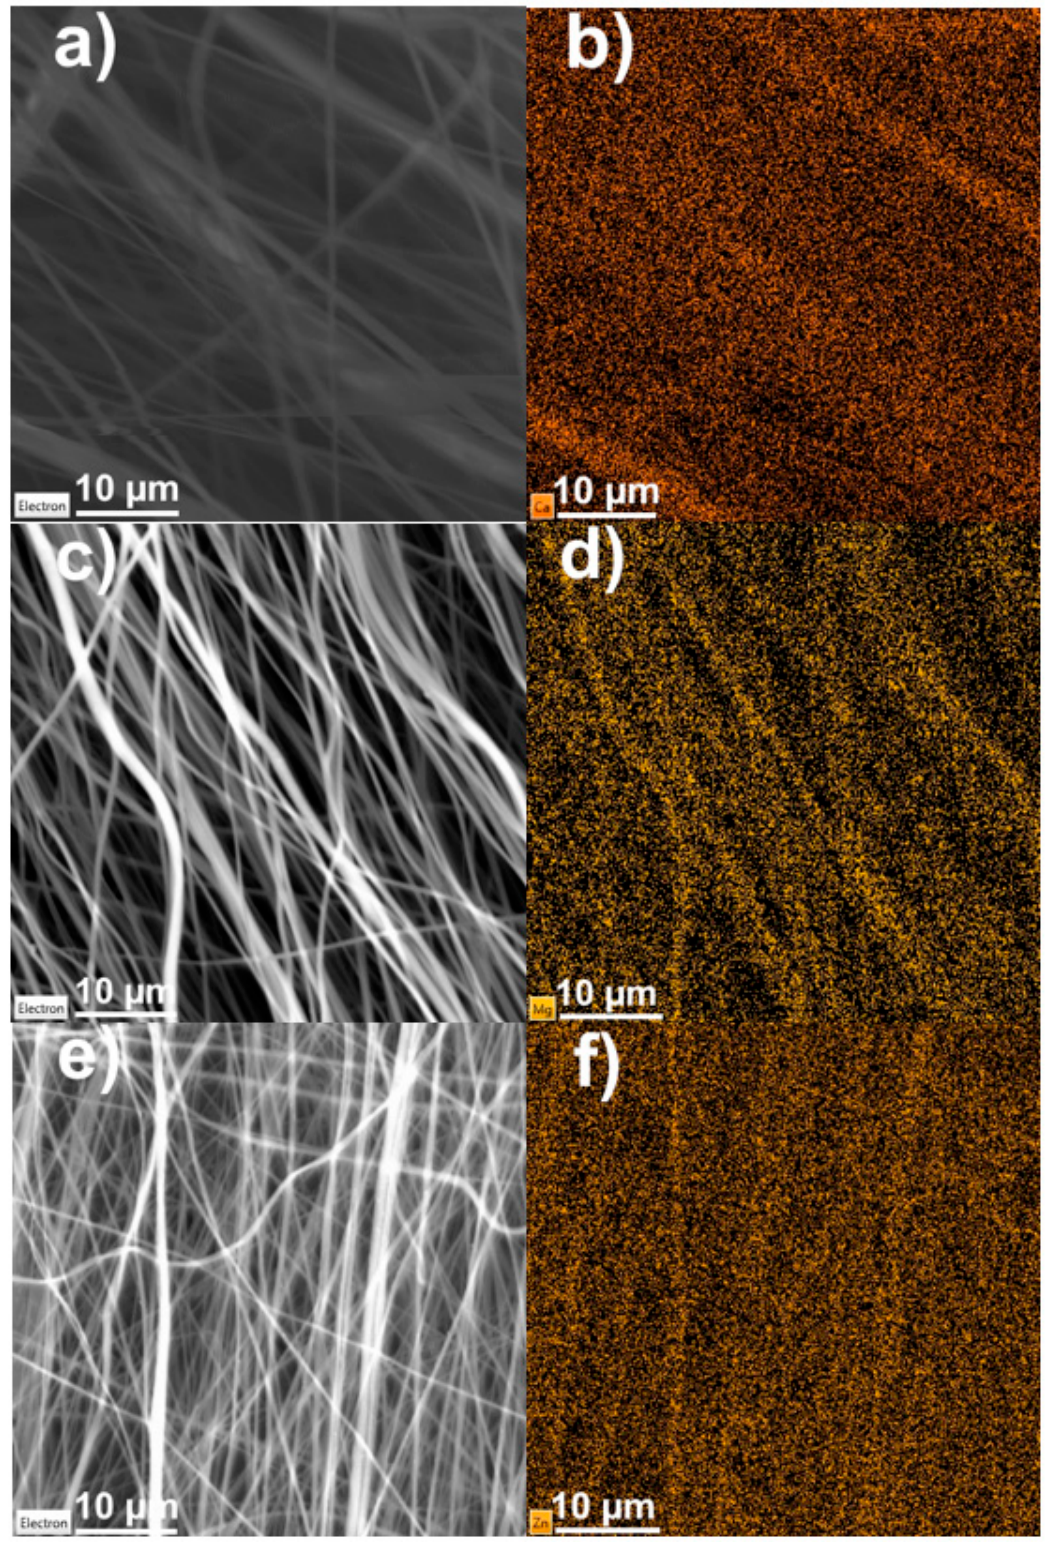
Figure 8. SEM and EDX images of salt-enhanced PVDF fibers, electron image and unique elements: ( a , b ) Ca(NO 3 ) 2 , ( c , d ) Mg(NO 3 ) 2 and ( e , f ) Zn(NO 3 ) 2 .